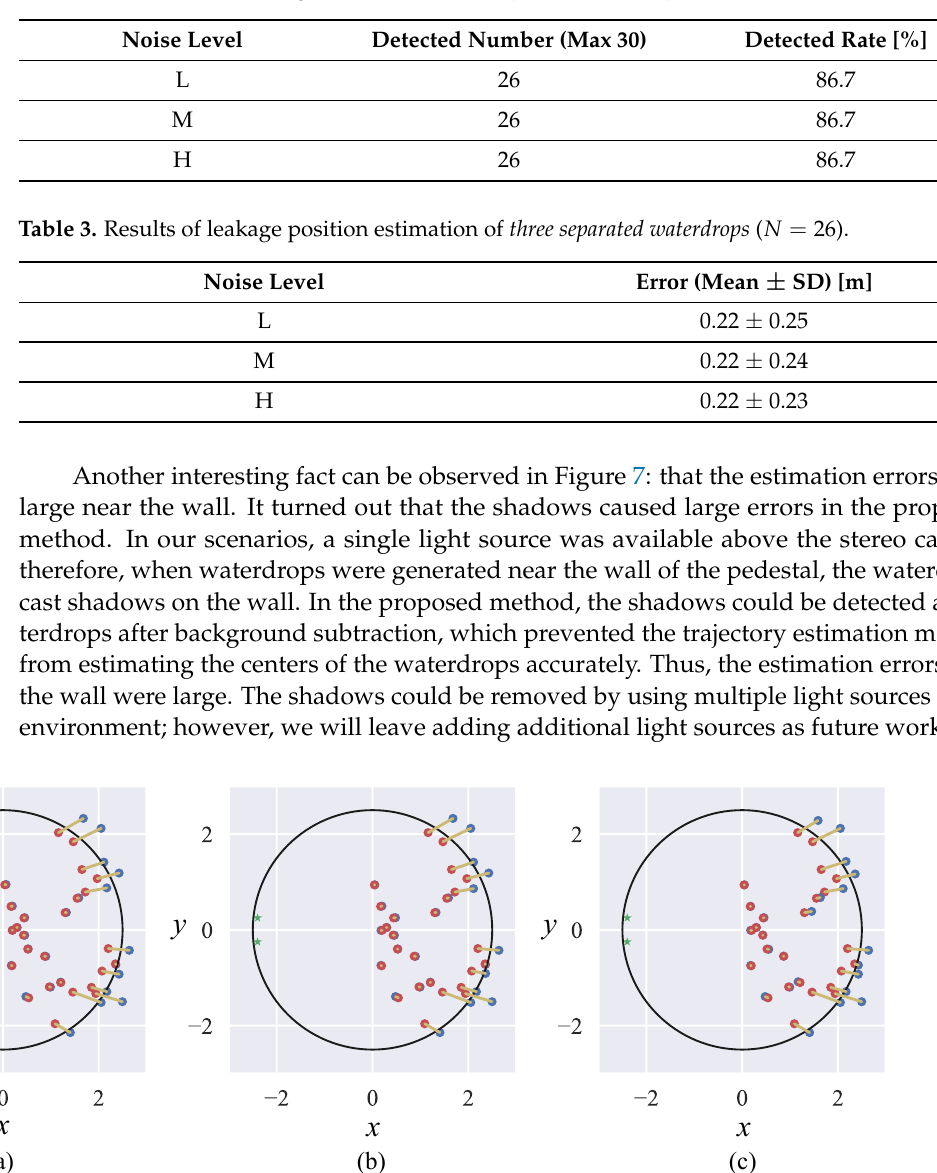
Table 2. Results of the leakage detection of three separated waterdrops .